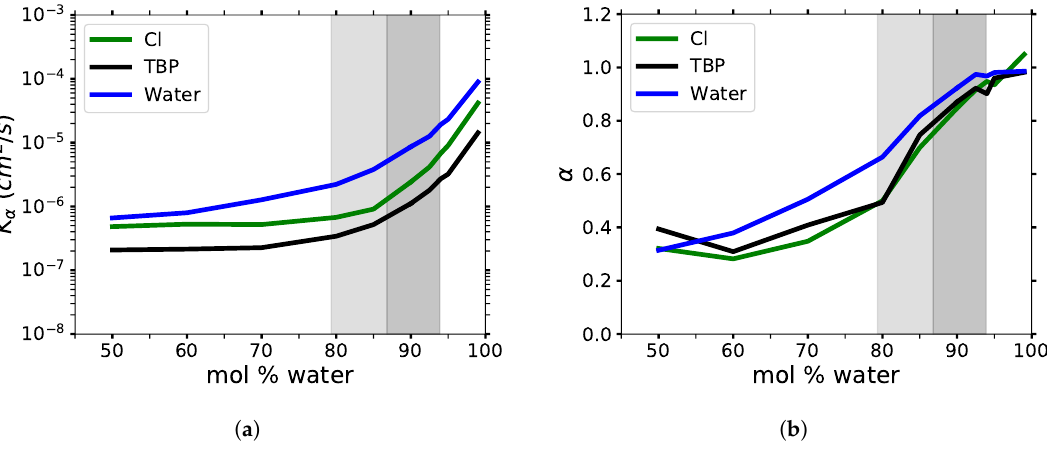
Figure A6. Anomalous diffusion coefficients in TBPCl–water at p = 1atm and T = 300K as a function of water concentration: ( a ) generalized diffusion coefficient, K α ; ( b ) anomalous diffusion exponent, α